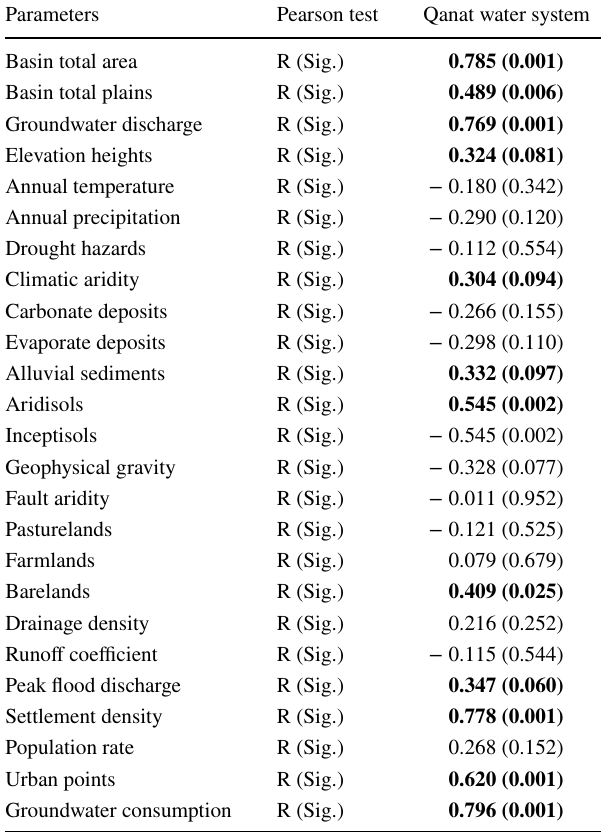
Table 10 Correlation coefficients between the Qanat system and envi- ronmental